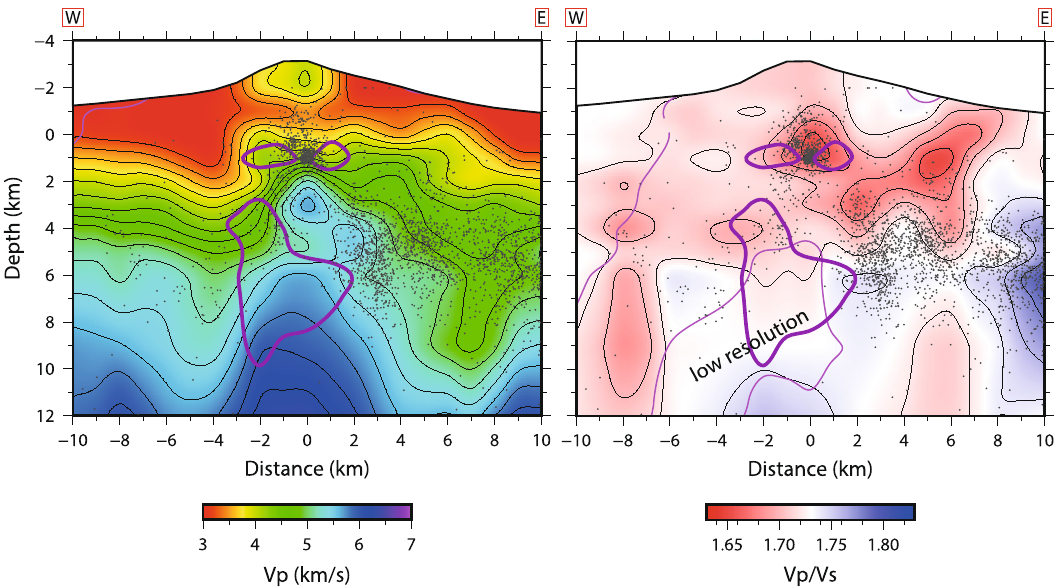
Fig. 7 Synthesis of the Mt. Etna plumbing system with Vp velocity changes. E-W vertical sections of Vp (left) and Vp/Vs (right) across the volcano, showing the past two years of seismicity. Purple lines indicate the extent of the volume with the Vp transient reduction. Note the poor low resolution of the Vp/Vs model in this central area due to the lack of S-waves passing through the melt